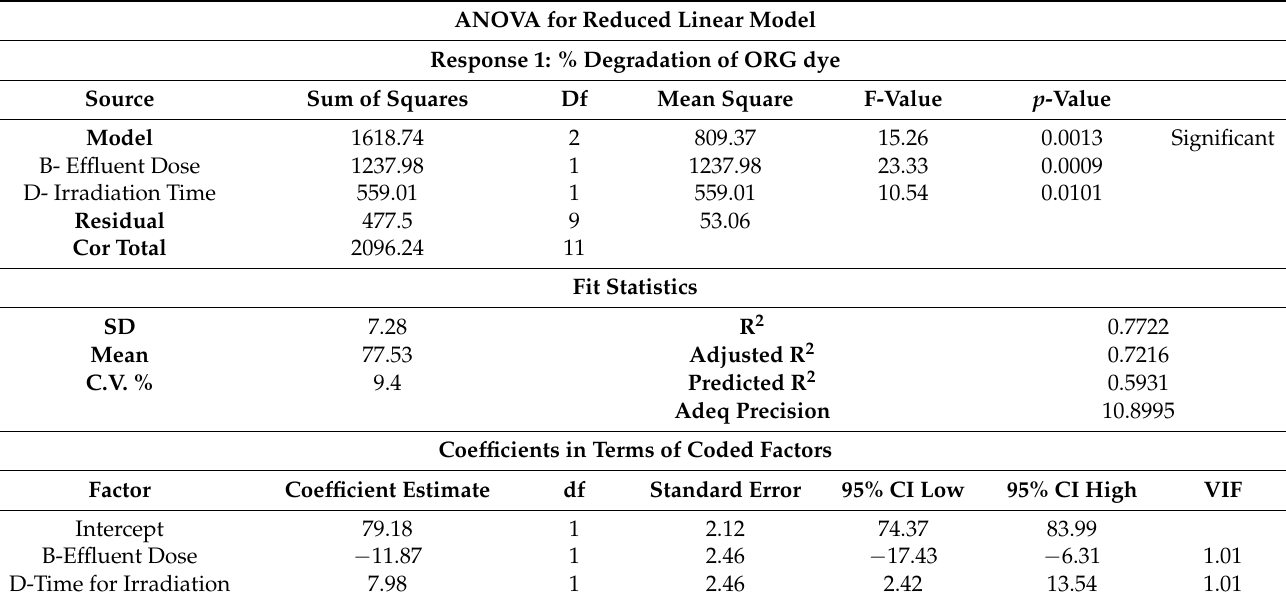
Table 2. ANOVA table, Fit Statistics, and Coefficients in Terms of Coded Factors. ANOVA for Reduced Linear